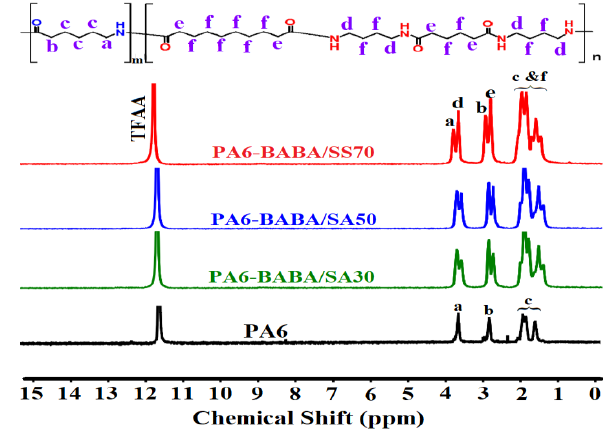
Figure 1. 1 H NMR spectra of virgin PA6 and PA6-BABA/SA with various wt % BABA/SA.